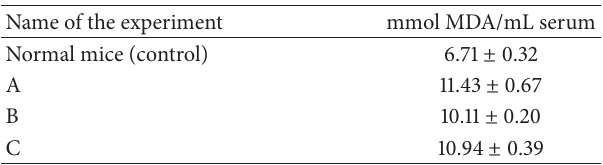
Table 10: The effect of test compounds on generation of MDA by lipid peroxidation in serum of normal